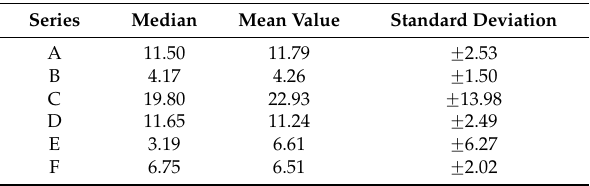
Table 6. Medians, mean values, and standard deviations of the surface roughness Sz ( μ m) taking all the primary crowns after the end of the test into account.